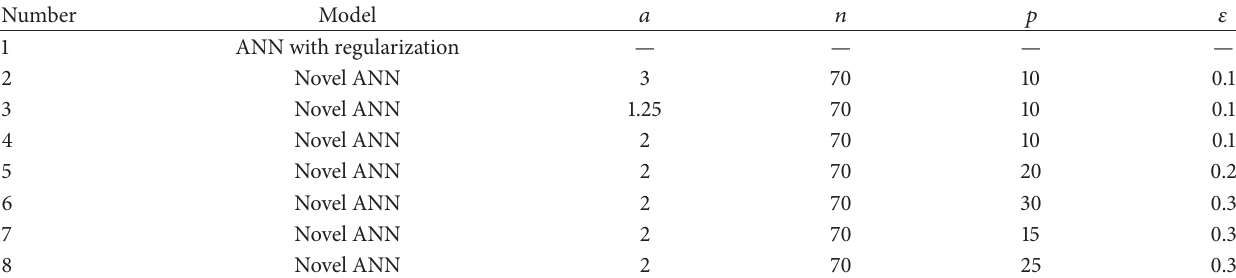
Table 5: Eight experiments are designed.